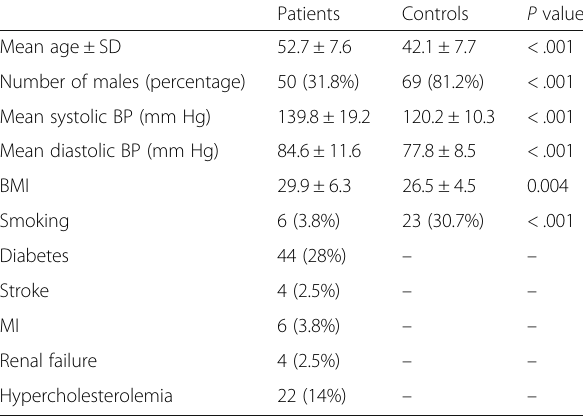
Table 2 Characteristics of patients and controls Patients